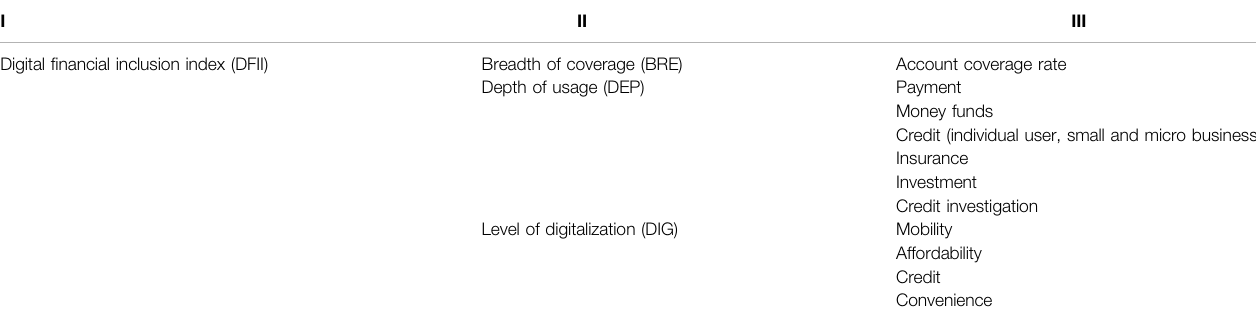
TABLE 2 | The construction of digital fi nancial inclusion index.